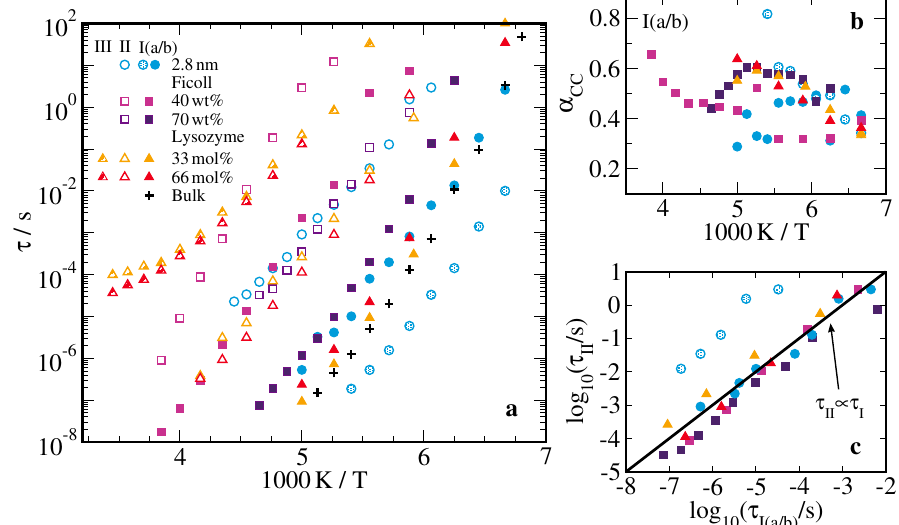
Figure 3. Results from broadband dielectric spectroscopy (BDS) studies on 66mol% D 2 O-DMSO- h 6 solution in various confinements and in the bulk [57]: ( a ) correlation times τ n of all observed relaxation processes and ( b ) width parameters α cc, n of processes I and Ia/Ib. Panel ( c ) shows τ II as a function of τ I or τ Ia/Ib . The solid line indicates a linear dependence. The used confinements are silica pores with a diameter of d = 2.8nm, ficoll at solution mass fractions of w s = 40wt% and w s = 70wt%, and lysozyme at a solvation level of s = 0.68 g sol / g lys . For the lysozyme confinement, results for 33mol% D 2 O–DMSO- h 6 solution are included for